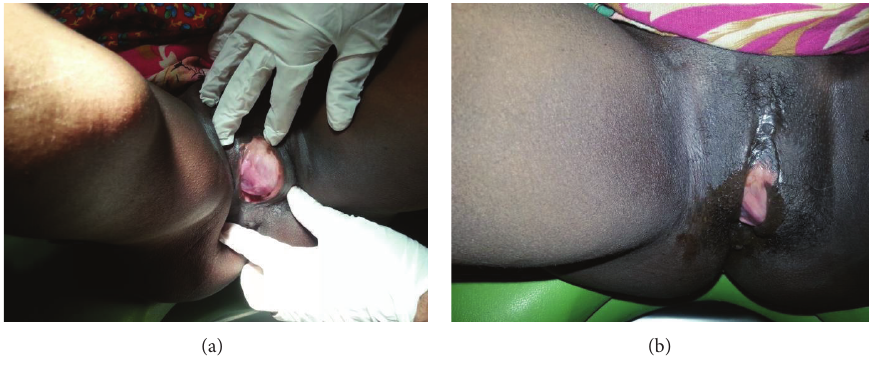
Figure 1: Preoperative inspection of vulvar region.